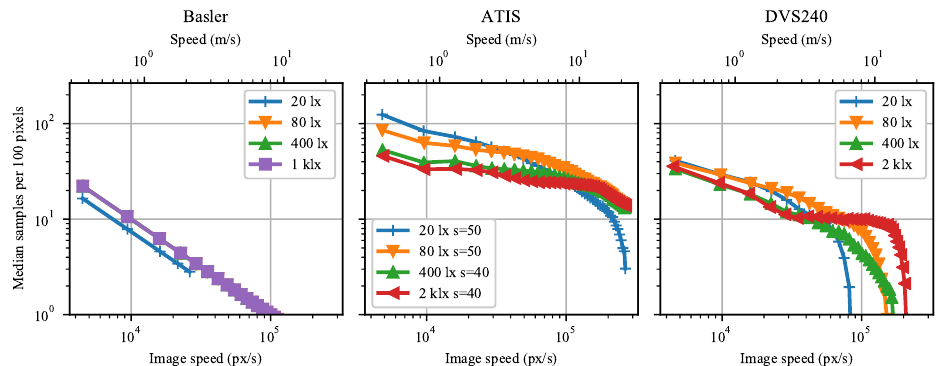
Figure 9. The median spatial sampling density in position estimates per 100 pixels distance as a function of dot image speed for Basler, ATIS, and DVS240 cameras. Each position estimate is computed from 100 negative polarity events. Data were measured for four background scene illuminance levels at the sensor